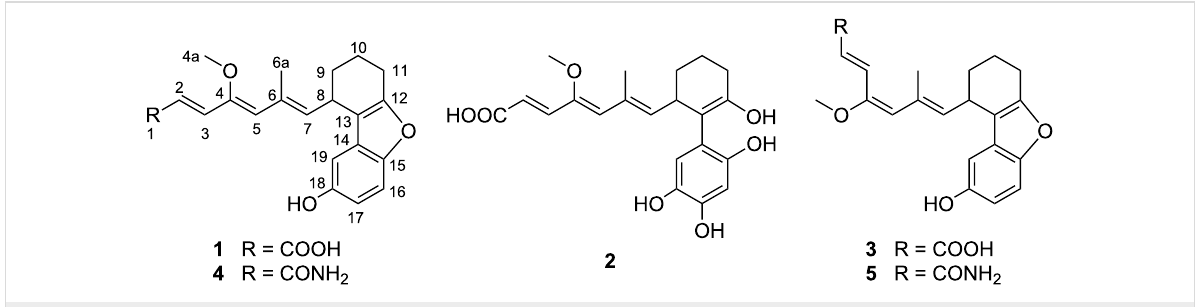
Figure 1: Cuevaenes A–E ( 1–5 ) isolated from Streptomyces sp.